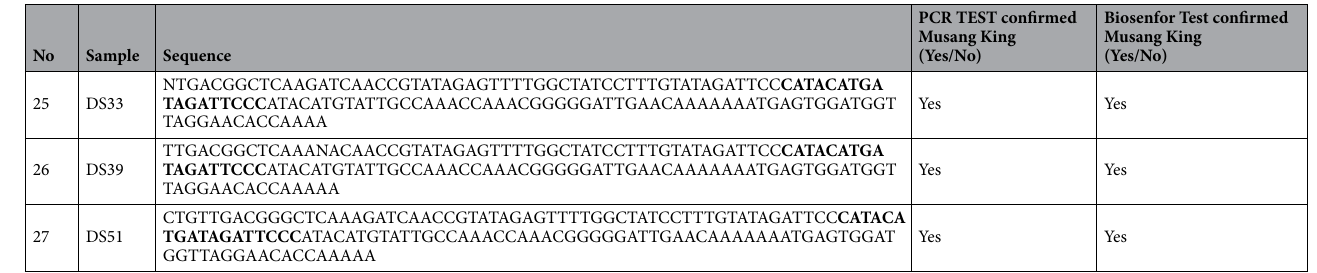
Table 1. Validation of 27 Durian samples by sequencing of the PCR products in order to identify and validate MK variety from all samples. The bold area contains the unique sequence of MK variety based on nadhA gene sequence.